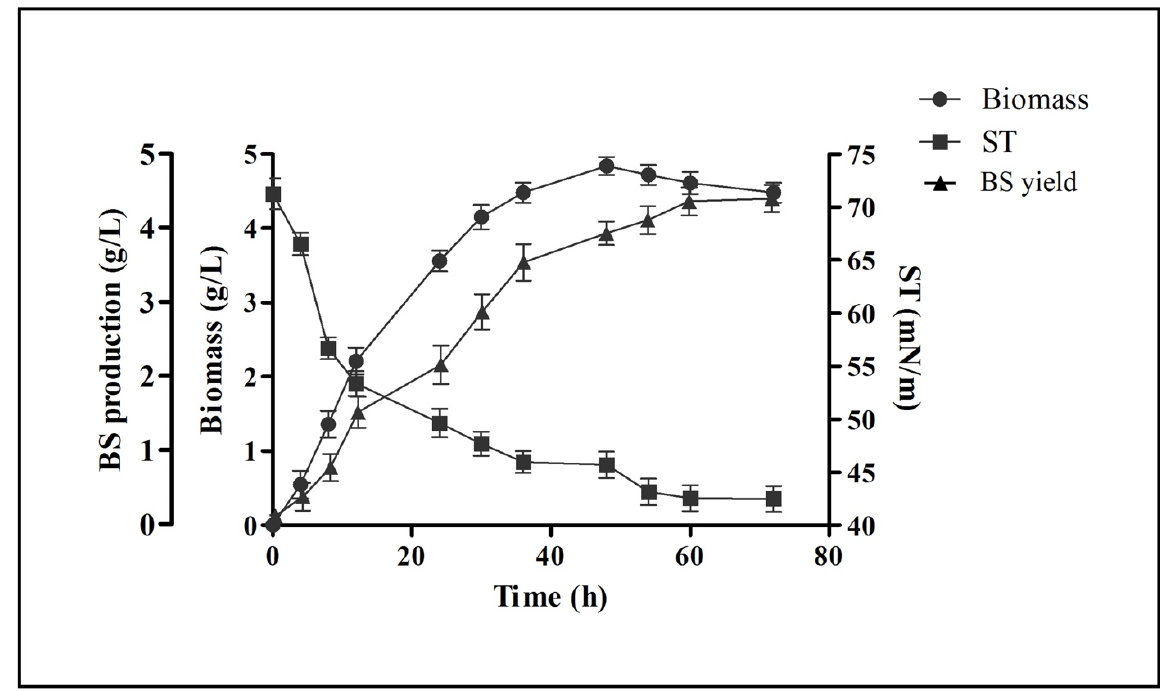
Figure 1. Profiling of the growth kinetics of L. rhamnosus in reference to the reduction in surface tension (ST) and production of biosurfactant (BS) at different time intervals. Values are the mean ± SD of three independent experiments.